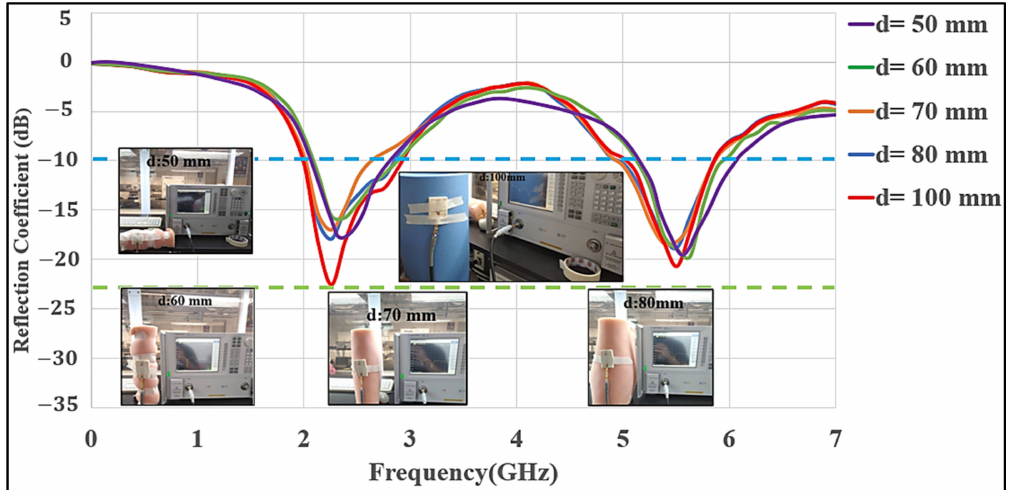
Figure 7. Measured S 11 of the MMAs deformed on various cylindrical curvatures (d = 50 mm, 60 mm, 70 mm, 80 mm, and 100 mm).